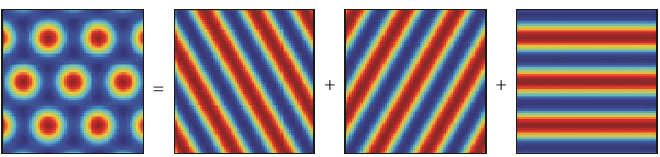
Figure 2: Grid cell 𝑔 𝑛 (𝑥,𝑦) function as the sum of three two-dimensional 0, 60, and 120 degrees out of phase sinusoids (from [13]).